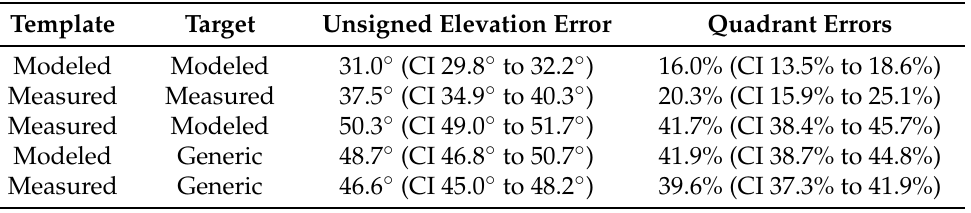
Table 1. Auditory-model-based predicted mean unsigned elevation errors and quadrant errors with the bootstrapped 95% confidence intervals.